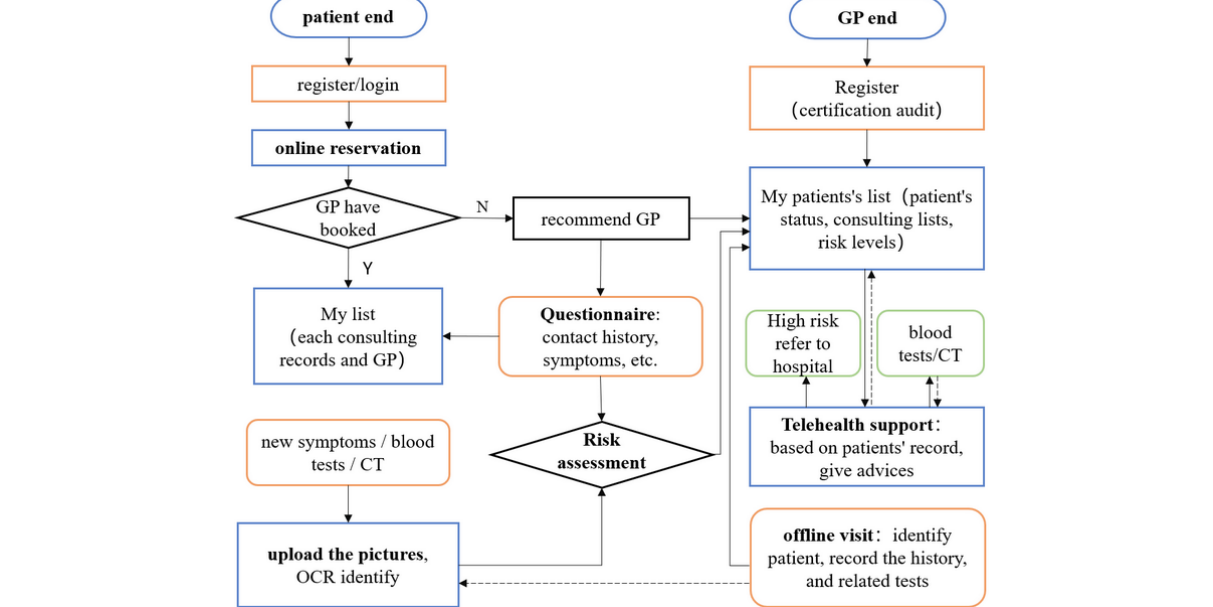
Figure 2. The main business flowchart of DDC19. CT: computed tomography; GP: general practitioner; OCR: optical character